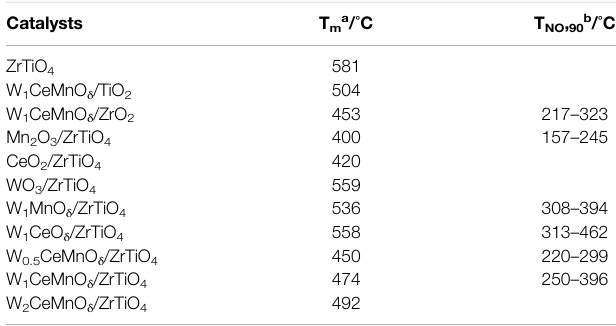
TABLE 1 | Peak temperature of maximum CO 2 concentration and 90% temperature window of NO conversion over 3DOM catalysts.